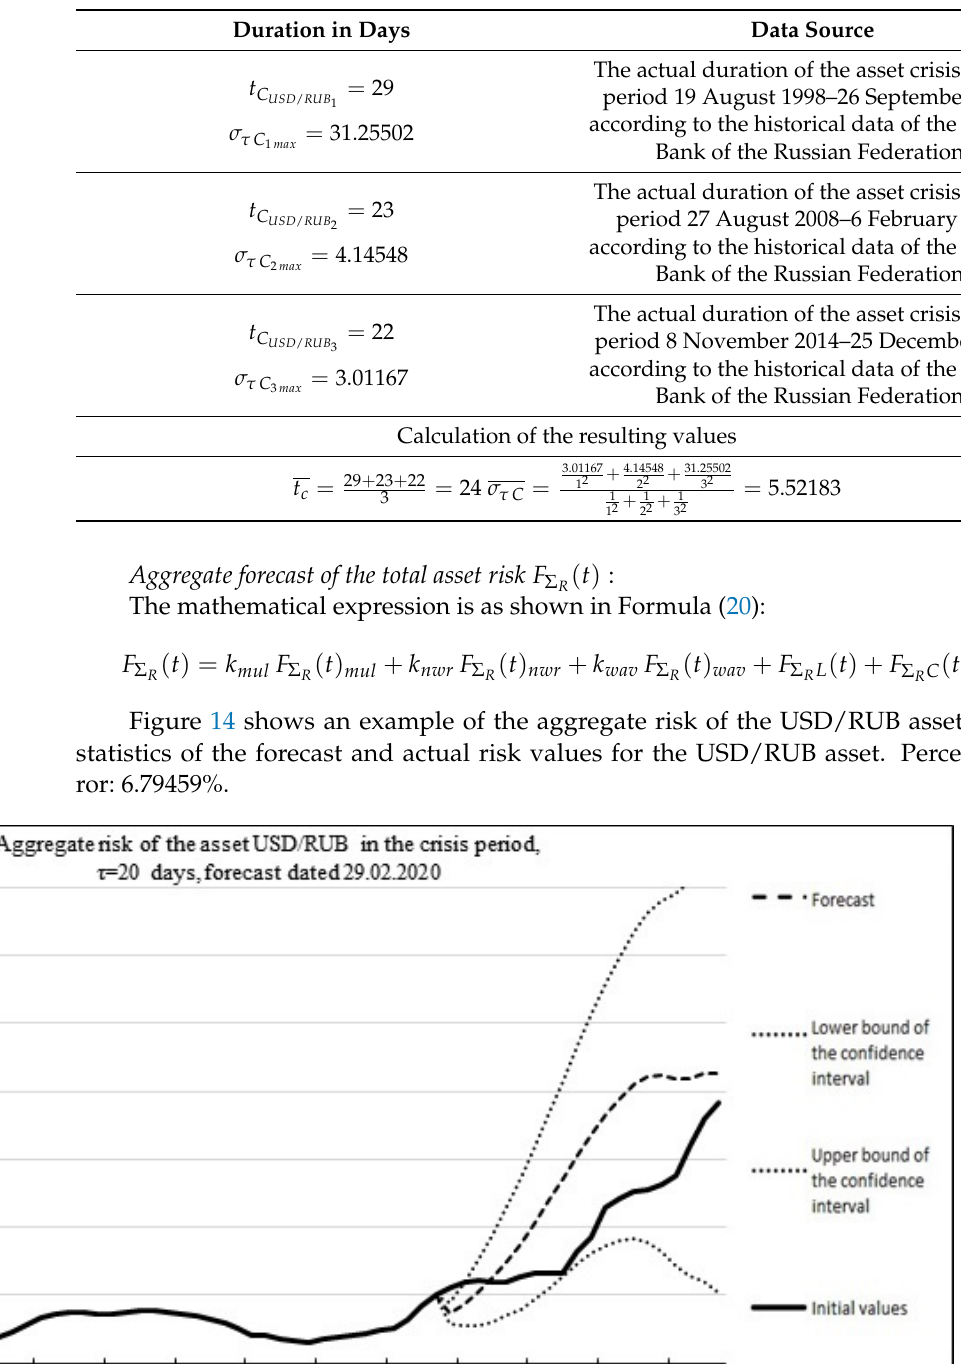
Table 5. Initial data for calculating the crisis risk.